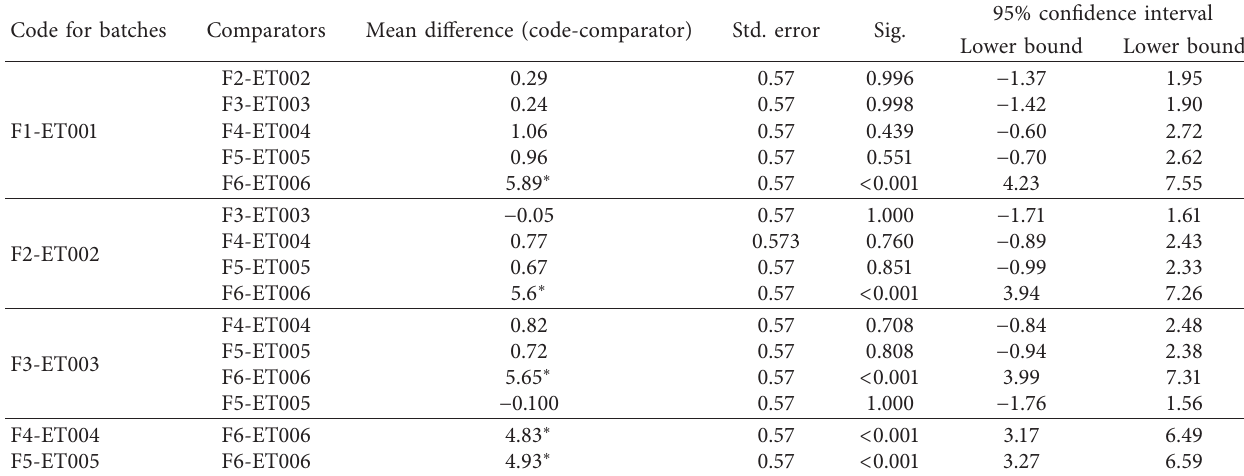
Table 4: Tukey’s multiple comparisons test for weight variation of ethambutol hydrochloride tablet batches tested with each other. Code for